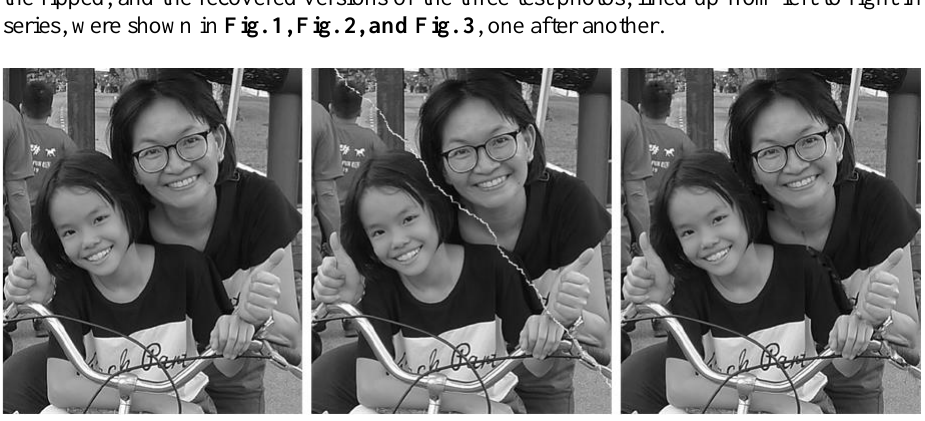
Fig. 1. The first test photo (portrait): the undamaged, the ripped, and the recovered versions were arranged from left to right in series.